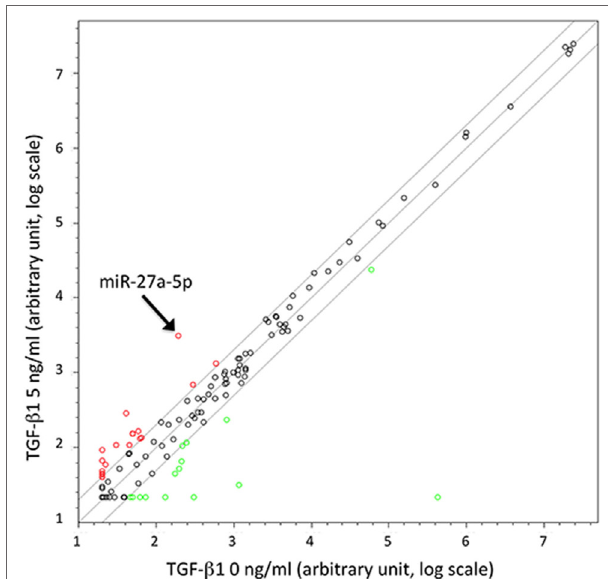
FigUre 1 | Scatter plot showing microRNAs (miRNAs) up- or downregulated in TGF- β 1-treated natural killer (NK) cells. Results are referred to NK cells from a representative healthy donor of three analyzed (donors 1, 2, and 3) treated with TGF- β 1 (5 ng/mL). Plot is referred to TaqMan Array Human MicroRNA Cards B (Applied Biosystems). Results are expressed as arbitrary units on a log scale. U6 snRNA has been used as reference control. miR-27a-5p is indicated by the arrow. Diagonal lines represent the 2, 1, and 0.5 values for fold induction.